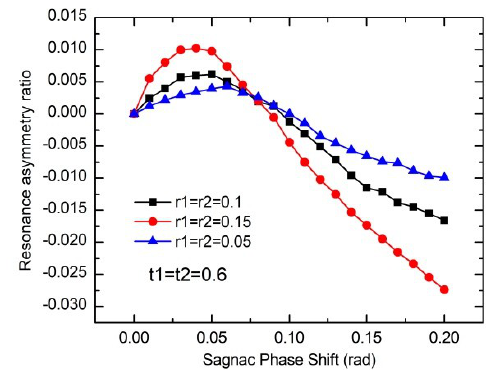
Figure 16. The influences of the Sagnac phase shift on the reonance asymmetry degree considering the backreflection noise.